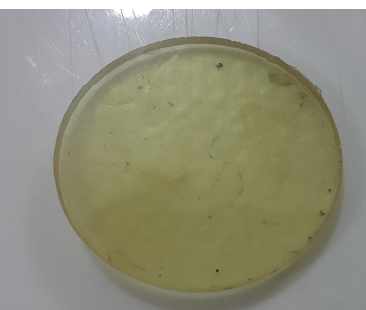
Fig. 4. Tensile test standard Fig. 5. Water absorption specimen.